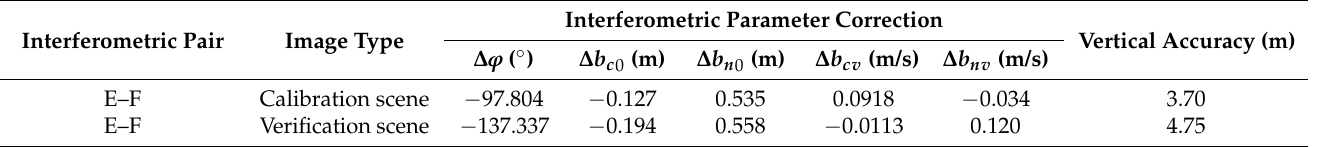
Table 7. Accuracy evaluation results of the verification scene